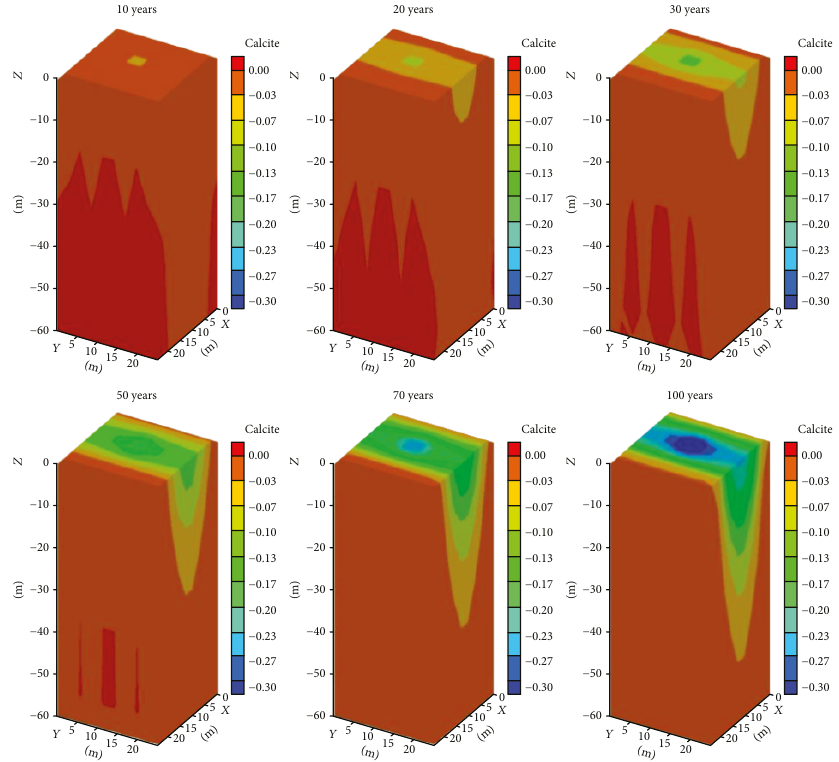
Figure 11: The corrosion range of the fi ssure under medium hydrodynamic conditions-medium permeability — 20 ° C.